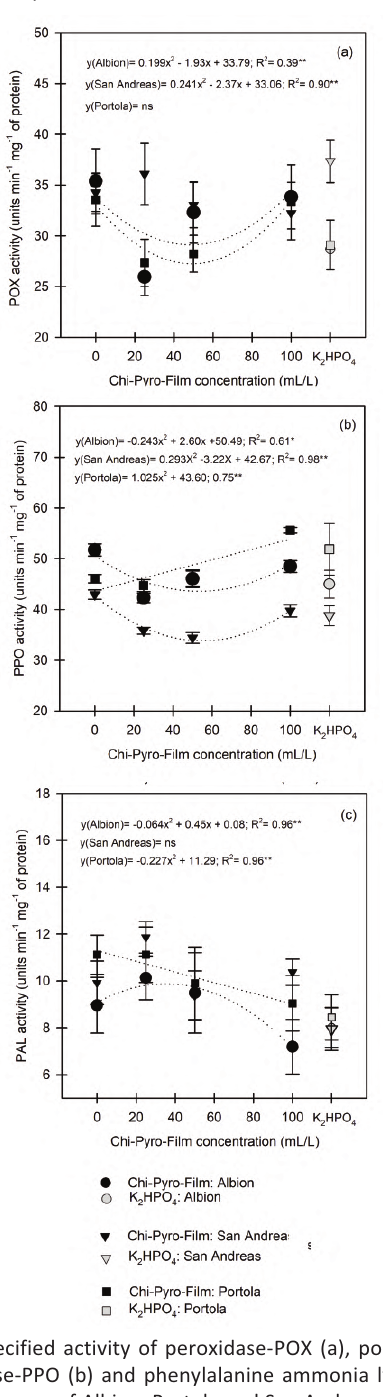
Fig. 7 ­ Specified activity of peroxidase­POX (a), polyphenoloxi­ dase­PPO (b) and phenylalanine ammonia lyase­PAL (c) in leaves of Albion, Portola and San Andreas, in response to Chi­Pyro­Film concentrations and reference treatment (K HPO , 50 mM). Interaction effect between film con­ 2 4 centration and cultivars. *, **, ***, significant at p<0,05, p<0,01, e p<0,001,